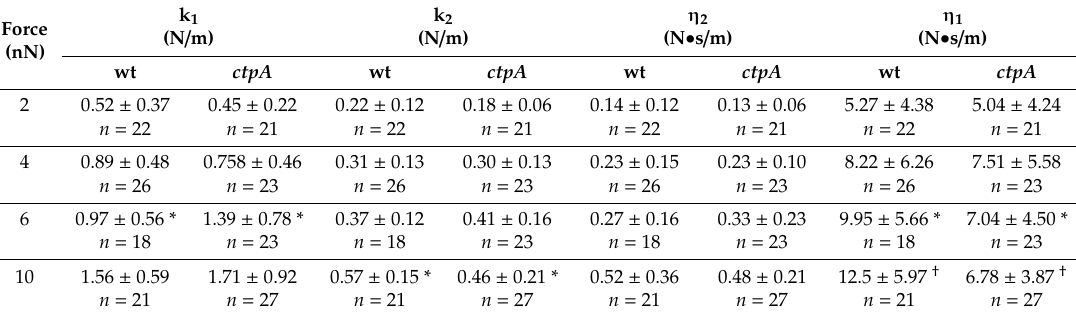
Table 2. Best-fit viscoelastic constants of R. leguminsarum bv. viciae 3841 (wt) and 3845 ( ctpA ) as a function of loading force. k 1 , k 2 , η 2 , and η 1 were fit from the four-element Burgers model [47].